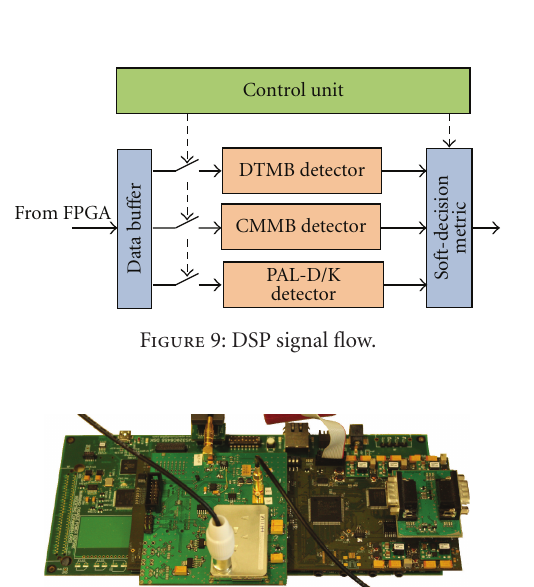
Figure 12: Simulation and measurement results for CMMB ( t sense =